Question: Briefly state, in one sentence, what is plotted here.
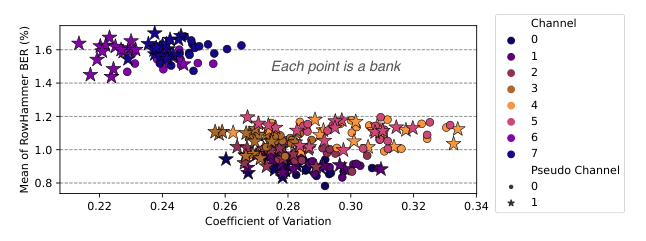
Answer: BER variation across banks. Each bank is represented by the average BER (y-axis) and the coefficient of variation in BER (x-axis) across all rows within the bank.